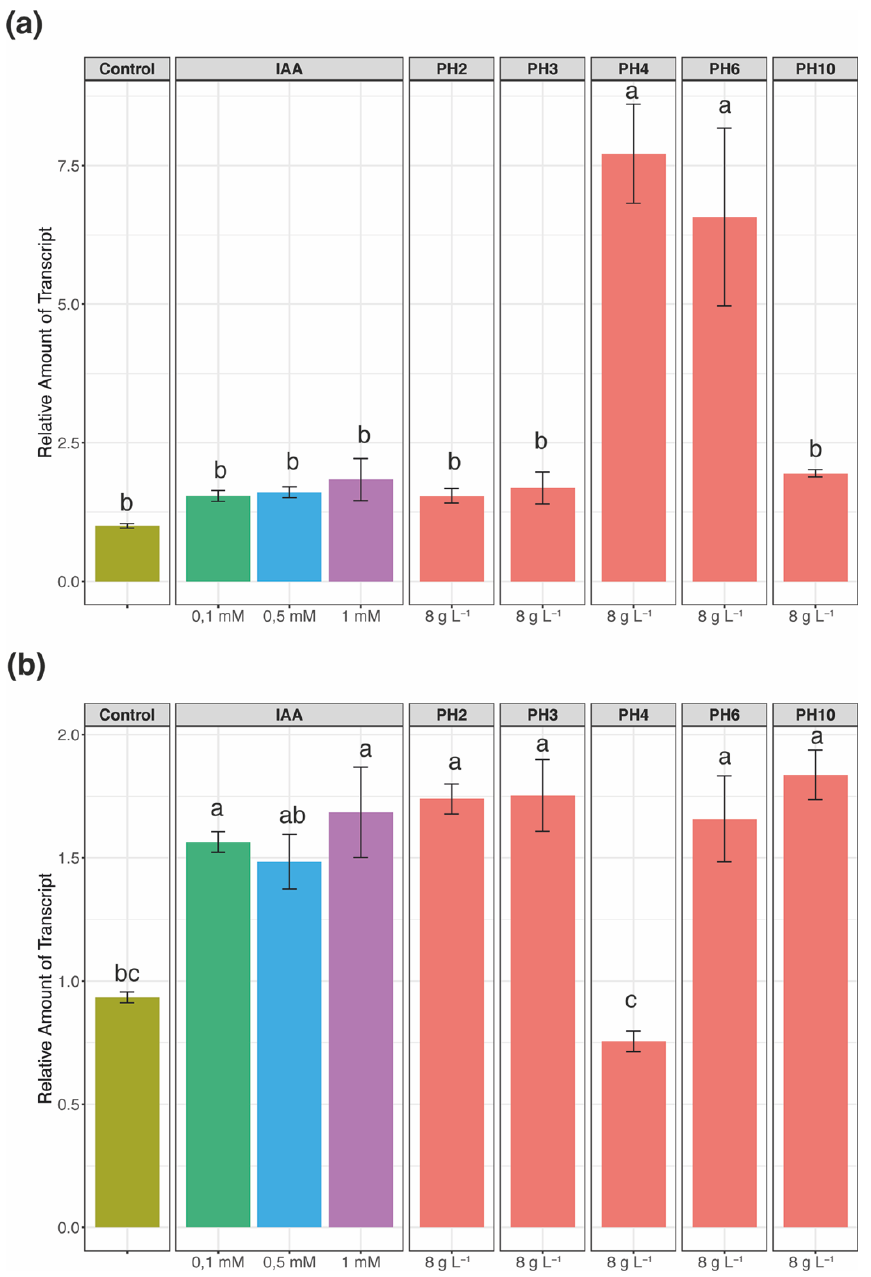
Figure 2 . Quantitative RT-PCR analyses of selected IAA-responsive transcription factors. ( a ) SlIAA2 and ( b ) SlIAA9 . The assessment was carried out on leaf tissue of tomato plants at 7 days after treatments. The data were normalized to the Elongation Factor 1 α housekeeping genes. The relative expression ratios were calculated using control plants as a calibrator sample. The values reported are means SE of three biological replicates. Different letters indicate significant differences according to one-way ANOVA with Tukey post hoc tests ( p < 0.05).